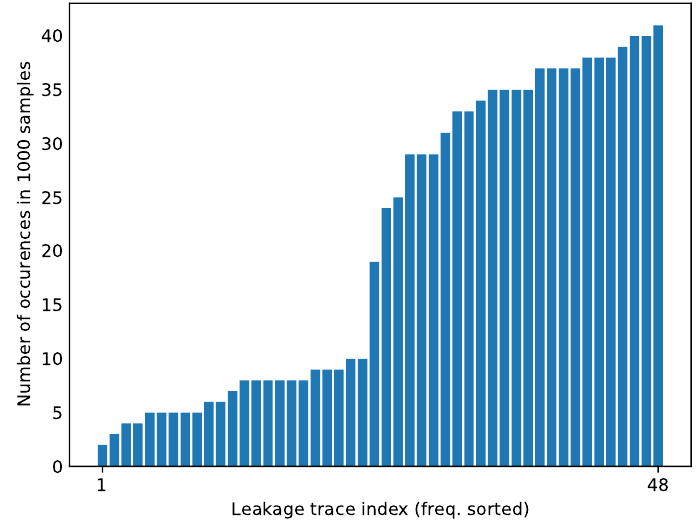
Figure 6: libgcrypt attack pmf